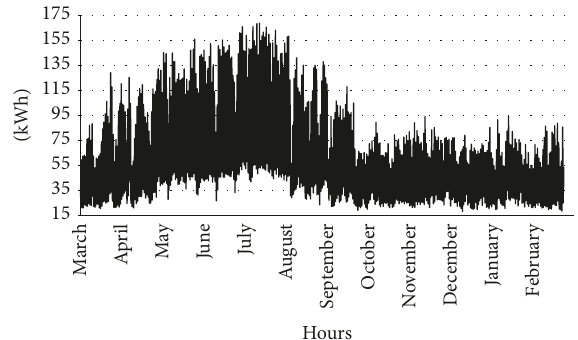
Figure 1: Hourly load data for 46 customers from 1 March 2013 to 28 February 2014.